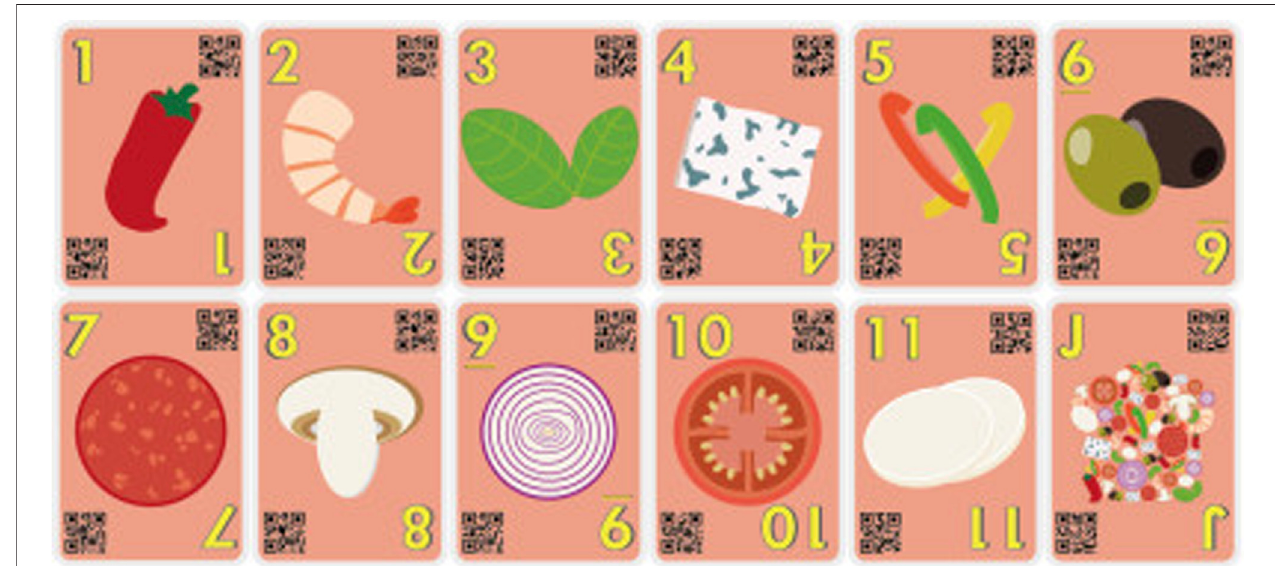
FIGURE 2 | Ingredient cards and the joker, with their corresponding face numbers. The lower the number, the rarer the card.